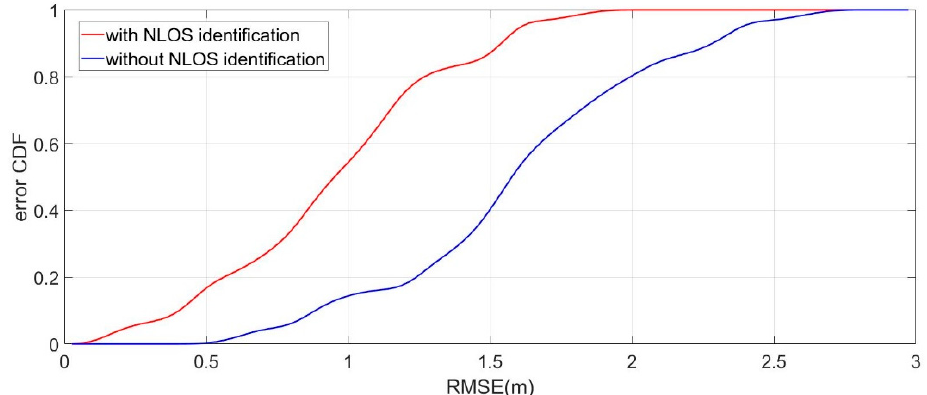
Figure 16. The results of the proposed localisation algorithm when NLOS identification is applied or